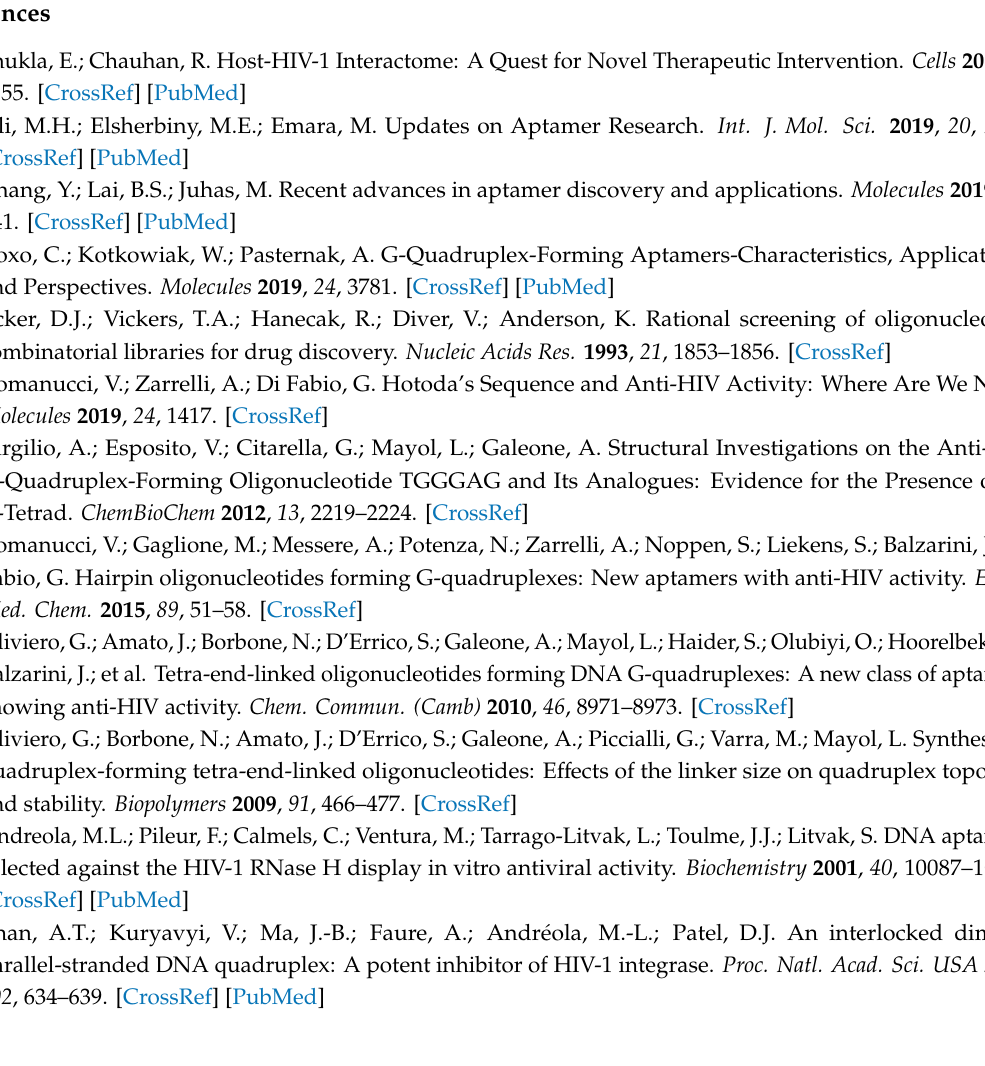
Figure S1: CD melting profiles in potassium bu ff er. Figure S2: CD heating profiles in the bu ff er of the integrase assay. Figure S3: Molecular models of INT-M2. Figure S4: Molecular models of INT-M10. Figure S5: Molecular models of